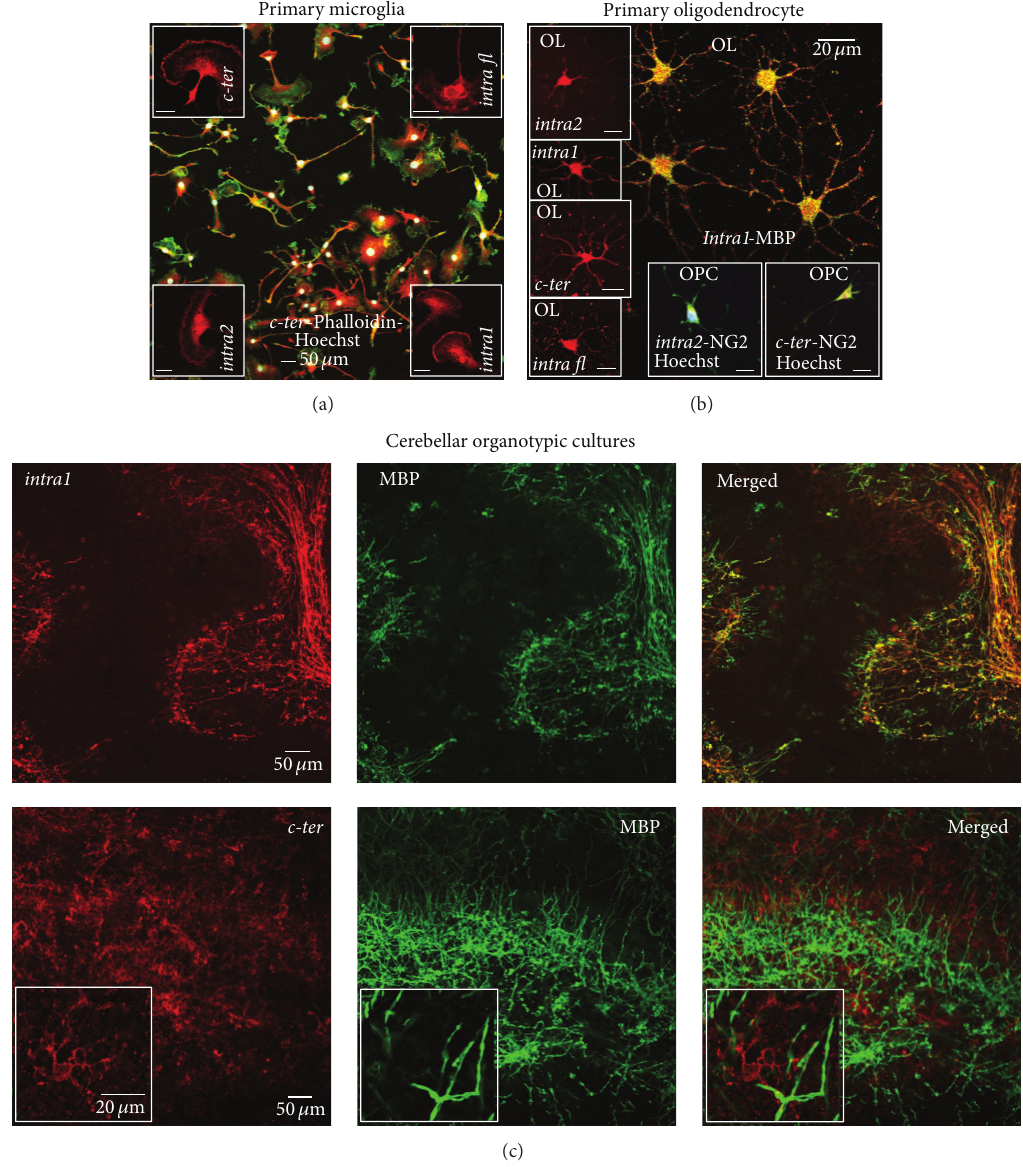
Figure 2: P2Y 12 receptor in dissociated and organotypic primary cultures. (a) Mouse primary cortical microglia were subjected to immunofluorescence and confocal analysis with phalloidin (green, merged field) and P2Y 12 receptor antibodies (red, insets and merged) and Hoechst (white, merged). Scale bars in insets: 20 𝜇 m. (b) Double immunofluorescence and confocal analysis of primary rat mature (OL) and precursor (OPC) oligodendrocytes was performed with antibodies for P2Y 12 receptor, MBP, NG2 (Table 1). For intra2 antibodies, lots AN01/02/04/0502/0602 were used. (c) Rat cerebellar organotypic cultures were analyzed by double immunofluorescence and confocal microscopy for intra1 (red) and c-ter (red), highlighting different structures (see also insets), and MBP (green).